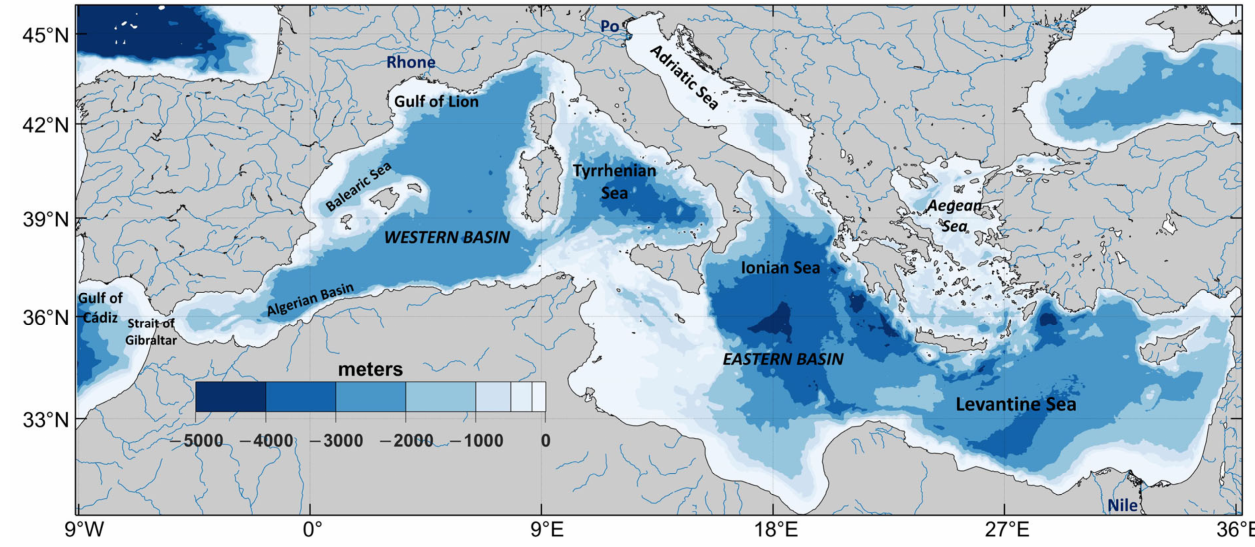
Figure 1. Map of the Mediterranean Sea bathymetry, showing the main basins, sea regions, and major